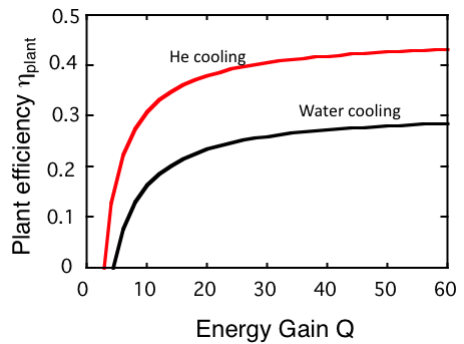
Figure 11. Plant efficiency η as a function of energy gain Q for high temperature plant Helium cooling (η = 0.49) and water-cooling (η th  = 0.03,  = 0.5,  = aux CD BD